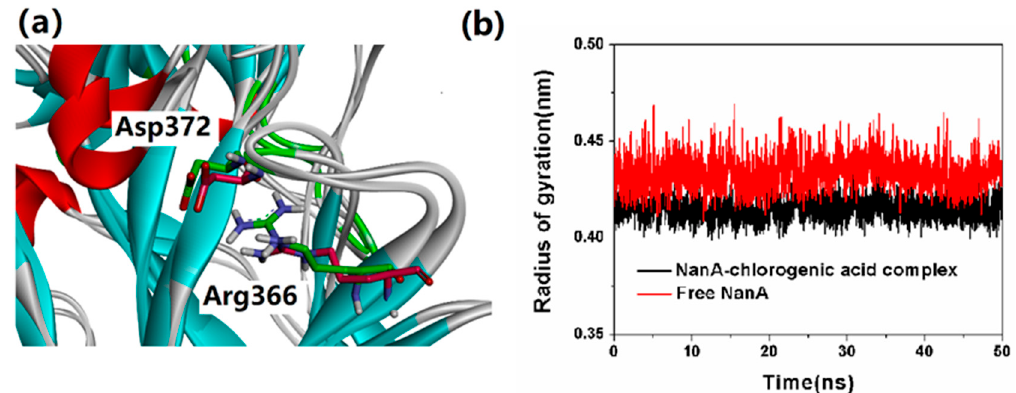
Figure 10. ( a ) The side chain direction of Asp372 and Arg366 in complex-NanA and free-NanA; ( b ) the radius of gyration of the loop in which Asp372 and Arg366 were located in complex-NanA and free-NanA.